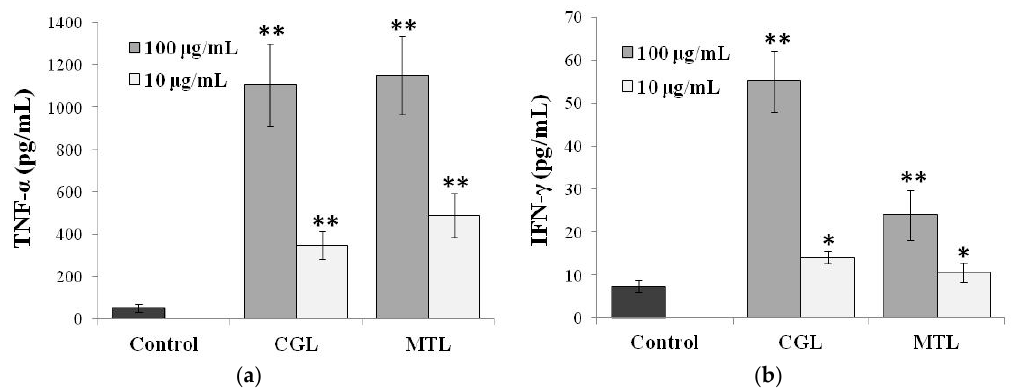
Figure 3. Cytokines-stimulation activity of CGL (unpublished data) and MTL [21] on spontaneous production of ( a ) TNF- α and ( b ) IFN- γ by HPBC. Cells were incubated for 24 h with or without lectin. The levels of cytokines in the culture medium were measured by sandwich enzyme-linked immunosorbent assay (ELISA). The ELISA data are expressed as mean ± SD of three separate experiments. * and ** indicate a significant difference at the level of p < 0.05 and p < 0.001, respectively, compared to control cells.